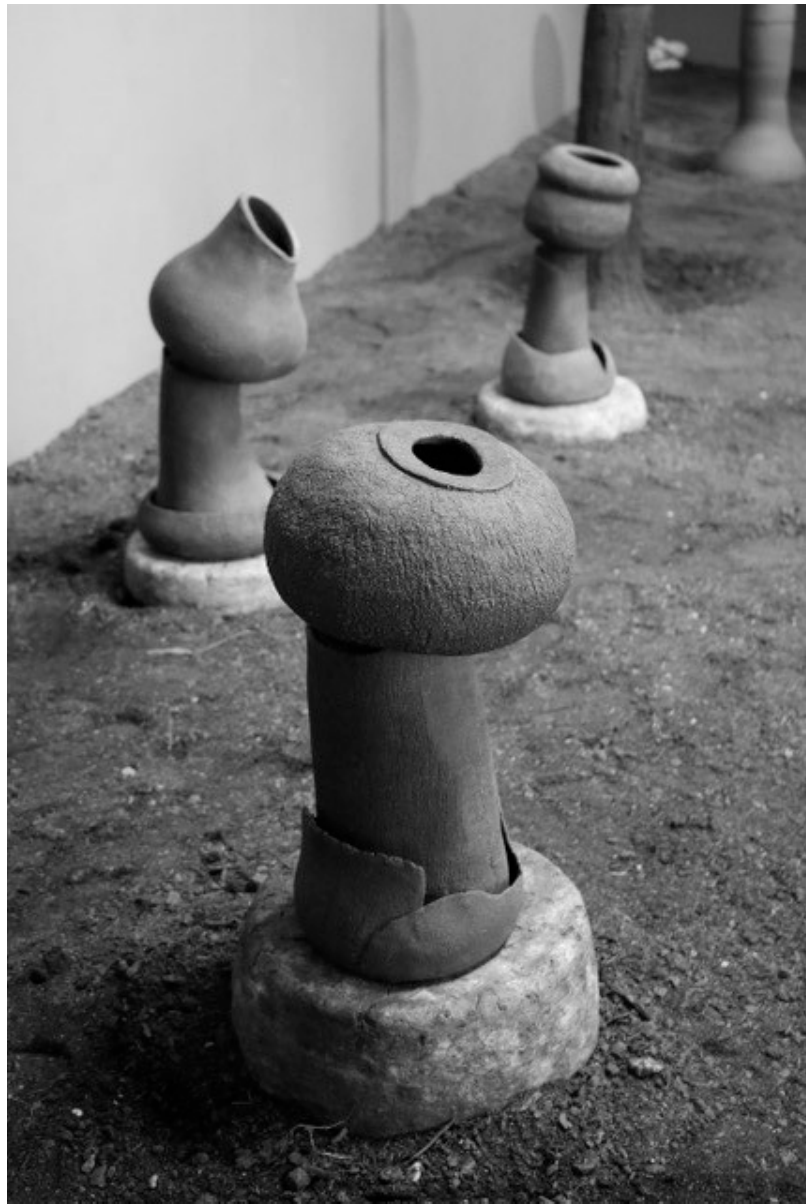
Figure 1. An artist’s impression of sounds in soil. This installation, created by Karine Bonneval, is entitled ‘Listen to the Soil’ and consists of a layer of soil and a set of 12 ceramic pieces (myxomycete fruiting body-like objects) that emit sounds from different types of soils. The installation was created in collaboration with Fanny Rybak, a bioacoustician at NeuroPSI, Orsay, Paris Sud University. Ceramics were made by Charlotte Poulsen, with the help of Diagonale Paris-Saclay and DRAC Centre-Val de Loire, Micro Onde art center. Artist Karine Bonneval was hosted by the Rillig lab. The installation is meant to offer observers another way to experience the typically invisible soil inhabitants through the sounds they produce. Photo by K. Bonneval, showing part of the installation.